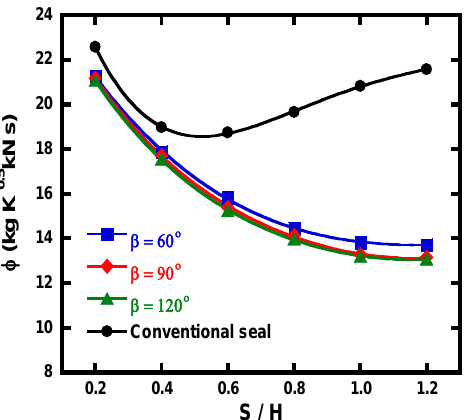
Figure 14. Variation in the flow function with S/H and β (PR = 2.5, t/K = 0.1). Despite the change in β , the difference between the flow function was not large because the rib height was not large, so we changed the reference rib height (from t/K = 0.1 to 0.2) and compared the rib inclination angle. Figure 15 shows the variation in the flow function with S/H for various rib inclination angles at t/K = 0.2. When compared with S/H = 1.0, the flow function decreases from 38.9% ( β = 60°) to 43.7% ( β = 120°) compared to the flow function of the conventional seal. As the size of β increases, the flow function decreases. At S/H = 1.0, the flow function is 4.3% higher at β = 60° and 4% lower at β = 120° compared to the reference value β = 90° at t/K = 0.2.